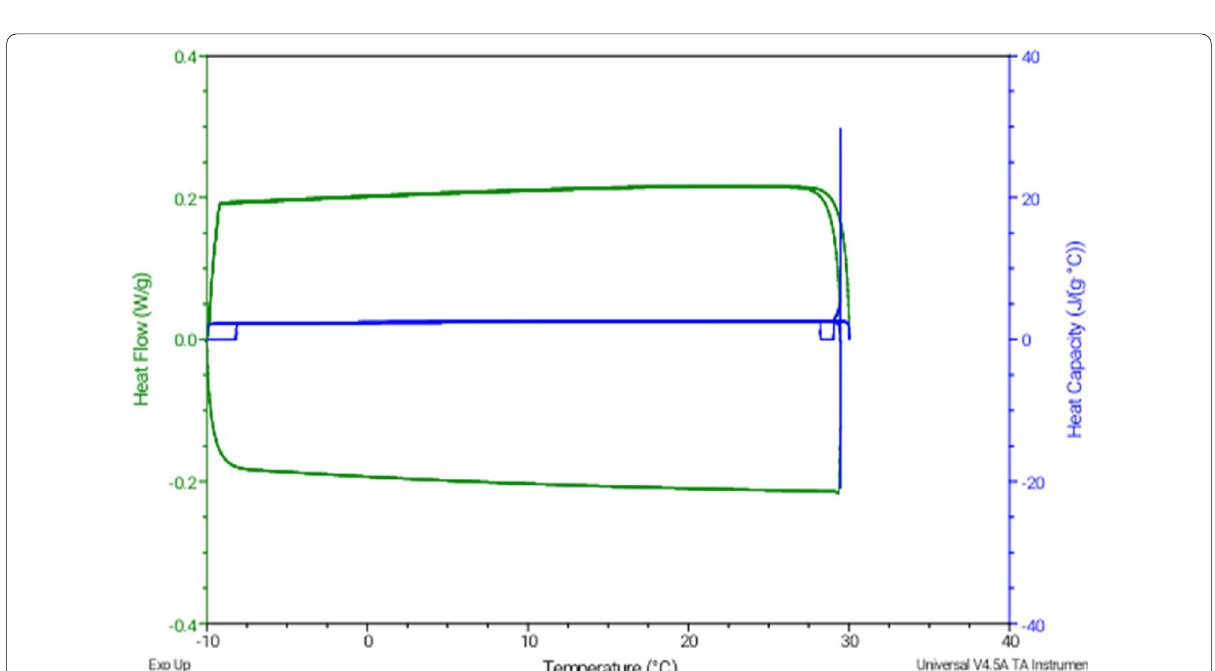
Fig. 6 DSC thermogram for crude